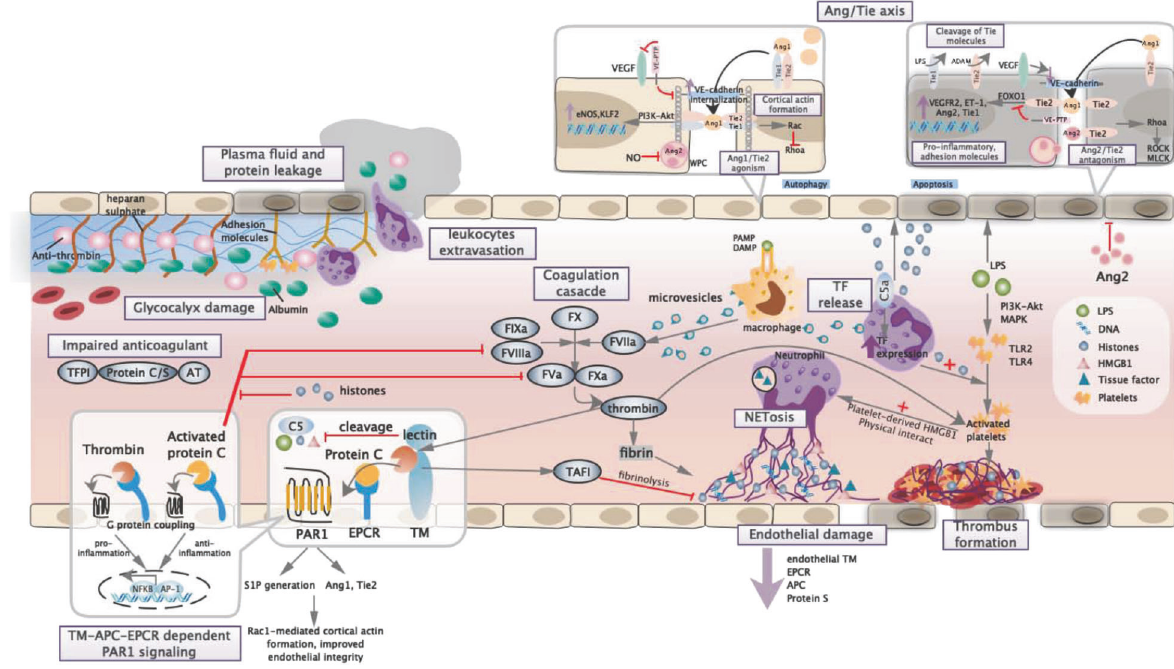
Fig. 3 Endothelial barrier and coagulation cascades. Lined by membrane-binding proteoglycans and glycosaminoglycan side chains, dearrangement of endothelial glycocalyx result in loss of anti-thrombogenicity and exposure of adhesion molecules, which allow